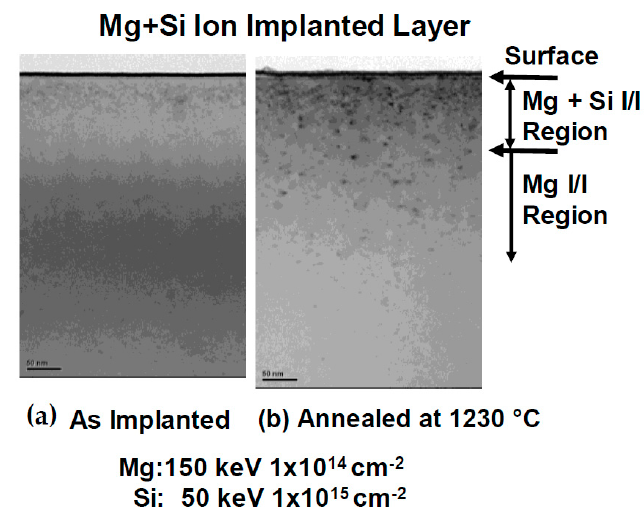
Figure 3. TEM images of double ion implanted layer of Mg and Si: ( a ) as-implanted, ( b ) annealed at 1230 °C.